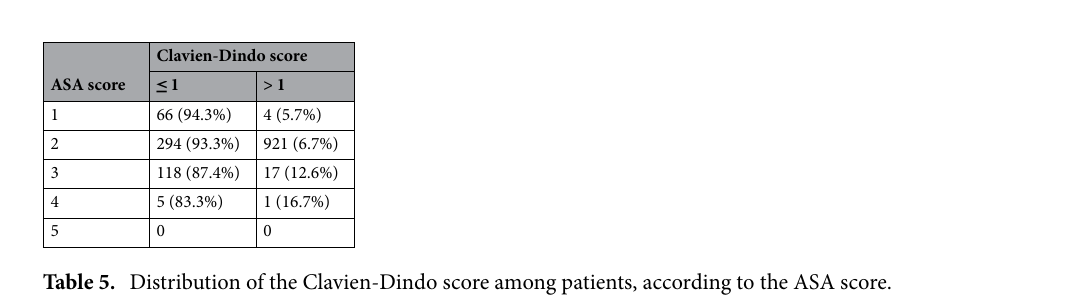
Table 5. Distribution of the Clavien-Dindo score among patients, according to the ASA score.